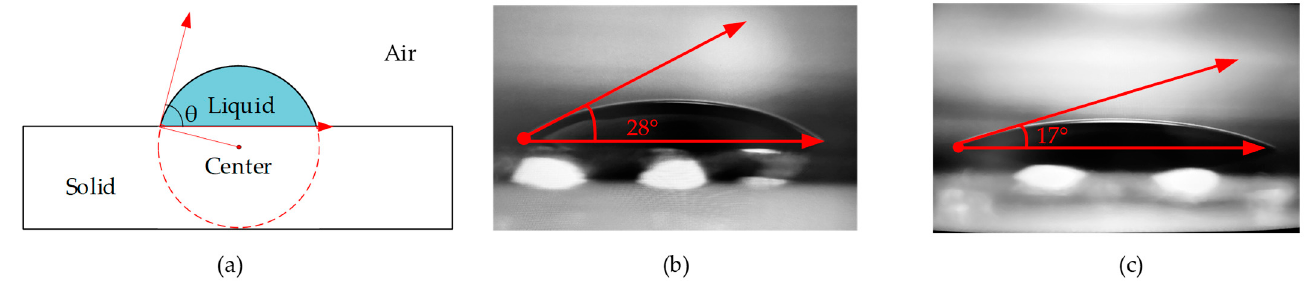
Figure 12. Measurement of the contact angle. ( a ) The principle of contact-angle measurement; ( b ) measuring the contact angle of water-based ink on Sithe ink products by the company of Asdun, Shenzhen, China); ( c ) measuring the contact angle of water-based ink on SiO 2 .